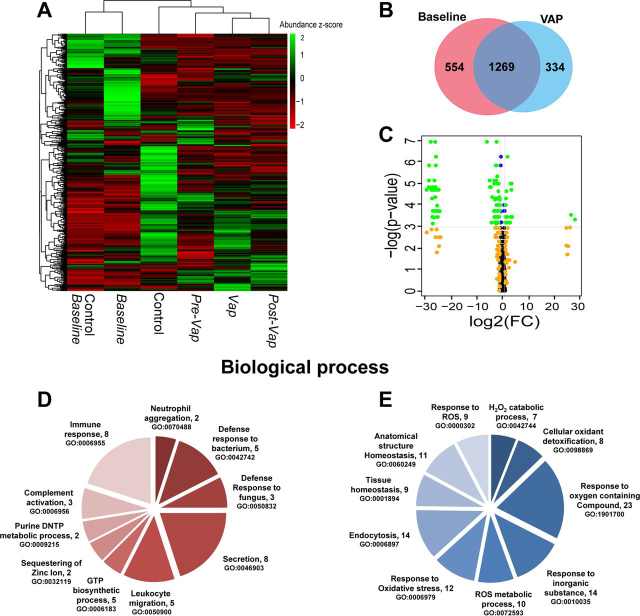
ETA proteome analysis.A, Temporal clustering of clinical time points using median protein abundance. B, Comparison of the Baseline and VAP positive ETA proteome in VAP patients. C, Significantly upregulated proteins in VAP patients; Volcano plot representing the ETA proteome with, (1) in blue, significant proteins (p < 0.05, Wilcoxon rank-sum test), (2) in orange, proteins for which the log2(FC) of the abundance (VAP positive compared with Baseline) > 1 or < −1, and (3) in green, significant proteins (p < 0.05) with log2(FC) > 1 or < −1 FC = Fold change. D, E, Gene Ontology (GO)-based functional enrichment analysis of significantly differentially abundant proteins in VAP positive compared with Baseline (biological process). Upregulated (left) and downregulated (right) GO categories (parenthesis). Baseline = day 1 of intubation for Control and VAP, VAP positive = day of VAP diagnosis, pre-VAP = a day before VAP, post-VAP = a day after VAP, Control = other intubation time points in control patients (day3 and day5).